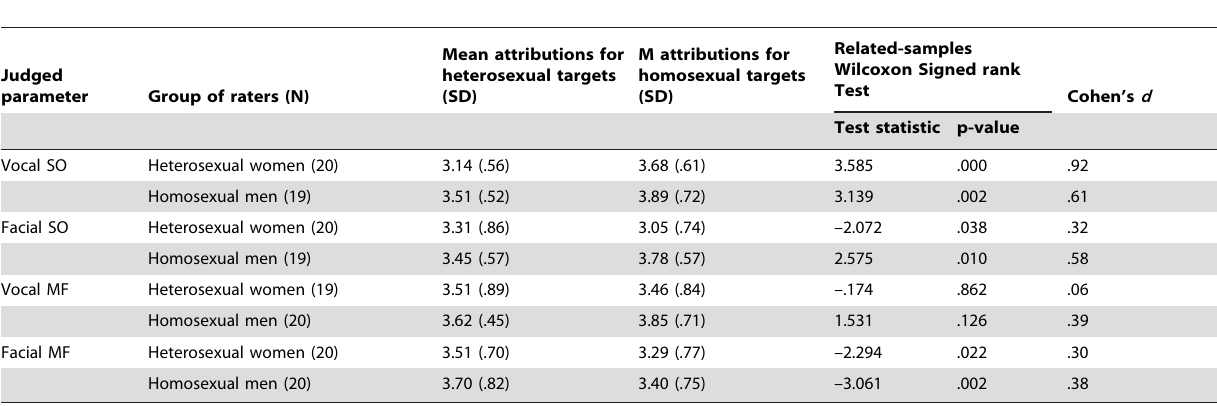
Table 1. Differences in sexual orientation (SO) and masculinity-femininity (MF) attributions between heterosexual and homosexual targets